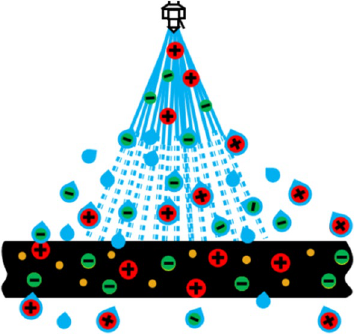
Figure 8. Diagram of charge transfer mechanism in the triboelectric charging